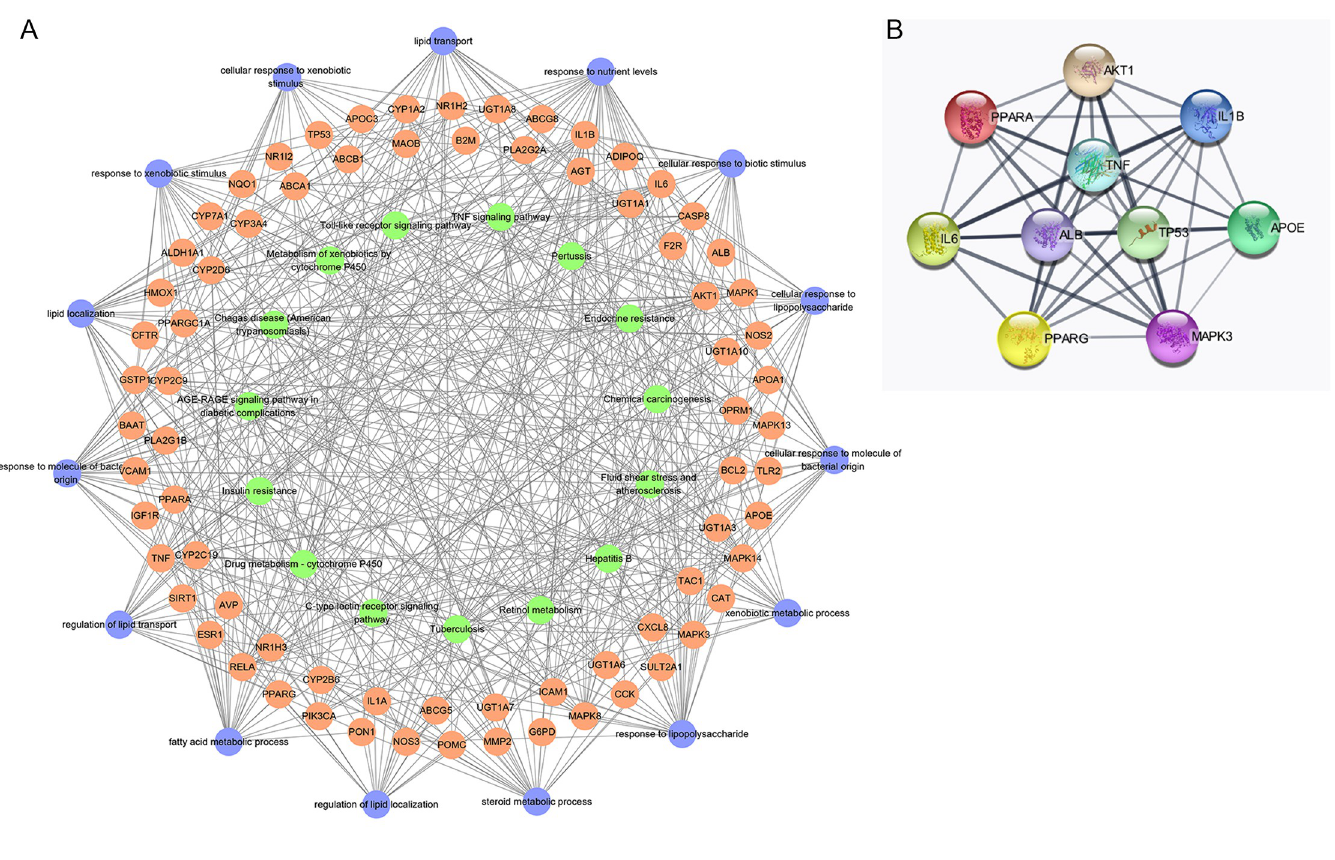
Fig 5. BP-target-pathway network and PPI network of top 10 hub genes for SHCZF against cholestasis. (A) The BP-target-pathway network included 83 potential targets (flesh-colored circles), top 15 BP terms (purple circles), and top 15 KEGG pathways (green circles). (B) PPI network of top 10 hub targets (ALB, IL6, AKT1, TP53, TNF, MAPK3, APOE, IL1B, PPARG, and PPARA) for SHCZF against cholestasis.